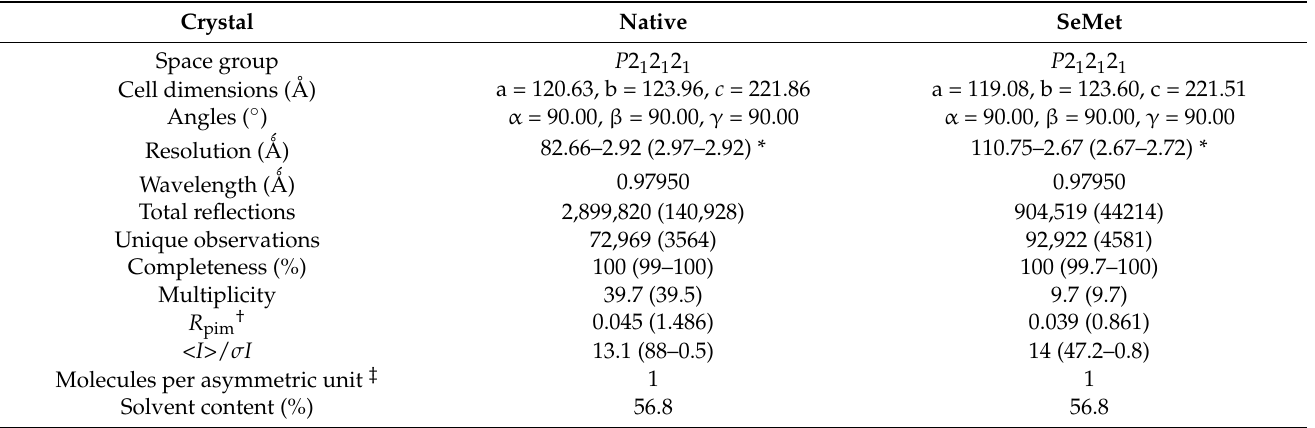
Table 1. X-ray diffraction data collection